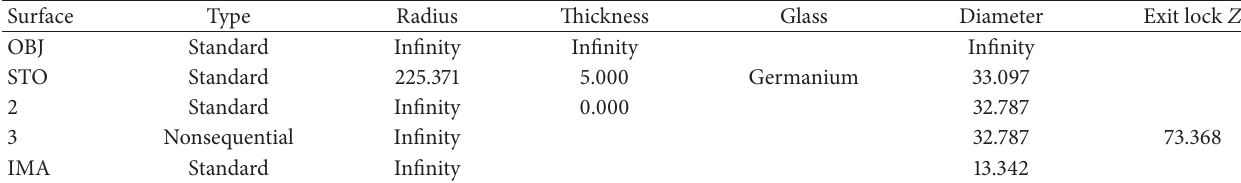
Table 4: Optical design of the binary germanium lens in nonsequential mode.